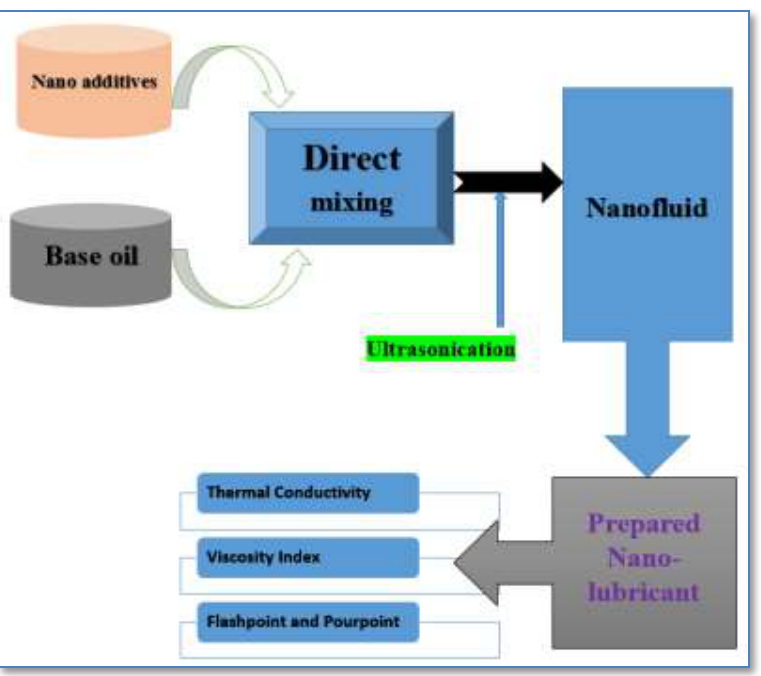
Figure 2: Schematic diagram of preparation stages of the nano- lubricating